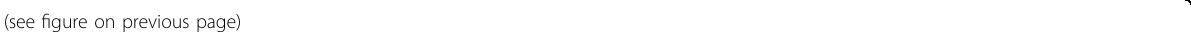
Fig. 2 Exogenous IL-26 activates bypass pathway of EGFR-TKI in mouse TNBC in in vitro assays. A Phase contrast microscopy of E0771 cells (1 × 10 4 ) following 48 h incubation with IL-26 or control vehicle in the presence or absence of ge fi tinib. Original magni fi cation, ×100. Scale bar, 100 μ m. Data shown are representative images of fi ve independent experiments with similar results. B E0771 cells were treated with the indicated dose of IL-26 in the presence or absence of ge fi tinib (20 μ M) for 48 h. * p < 0.01. C E0771 cells were treated with IL-26 (30 ng/ml) in the presence of various doses of ge fi tinib (5, 10, 15, or 20 μ M). * p < 0.01. D E0771 cells were treated with IL-26 (30 ng/ml) and/or ge fi tinib (20 μ M) in the presence of anti-IL-26 neutralizing mAb or isotype control mouse IgG (20 µg/ml, each) for 48 h. The dashed line is the standard value of ge fi tinib plus vehicle. E E0771 cells were stimulated with IL-26 (30 ng/ml) for the indicated periods, and then submitted to Western blot analysis using anti-phosphorylated AKT, JNK, ERK, p38, and STAT3 antibodies, and reblotting with anti-pan AKT, JNK, ERK, p38, and STAT3 antibodies. F E0771 cells were stimulated with IL-26 (30 ng/ml) in the presence or absence of ge fi tinib (20 μ M) for 15 min, and then submitted to Western blot analysis as described in E . G E0771 cells were treated with IL-26 (30 ng/ml) and/or ge fi tinib (20 μ M) in the presence or absence of various concentrations of signal inhibitors (AKT inhibitor, JNK inhibitor or combination of AKT inhibitor and JNK inhibitor) for 48 h. The dashed line is the standard value of ge fi tinib plus vehicle. * p < 0.01. B – D , G Cell proliferation was assessed by MTT assay. Representative data of fi ve ( B ) and three ( C , D , G ) independent experiments are shown as mean ± S.D. of triplicate samples, and similar results were obtained in each experiment. E , F Data shown are representative of fi ve independent experiments, and similar results were obtained in each experiment. Band intensity of phospho-proteins was normalized to the appropriate pan proteins, and relative intensity compared with unstimulated cells is shown as mean ± SEM from fi ve independent experiments. * p <